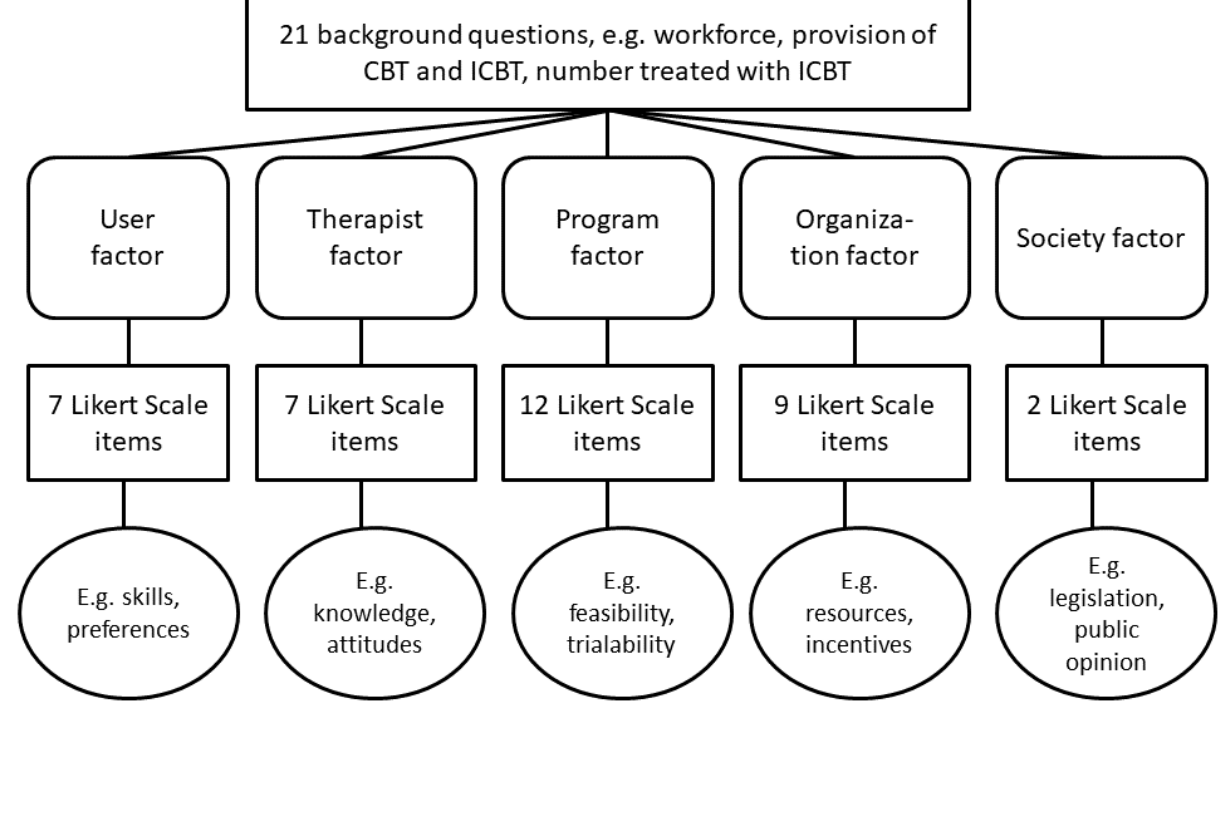
Figure 1. Survey